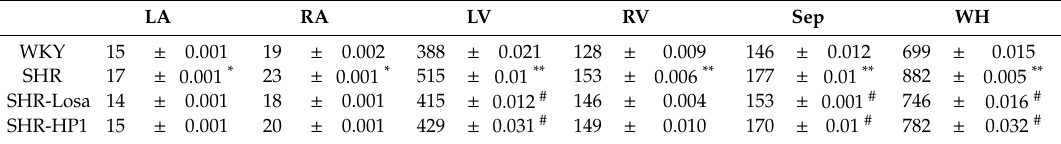
WKY, Wistar-Kyoto rat; SHR, spontaneously hypertensive rat; Losa, losartan; HP1, Vitis labrusca leaves extract; LA, left atrium; RA, right atrium; LV, left ventricle; RV, right ventricle; Sep, septa; and WH, Whole Heart. Values are expressed as the means ± standard error ( n = 10~12 for each group). * p